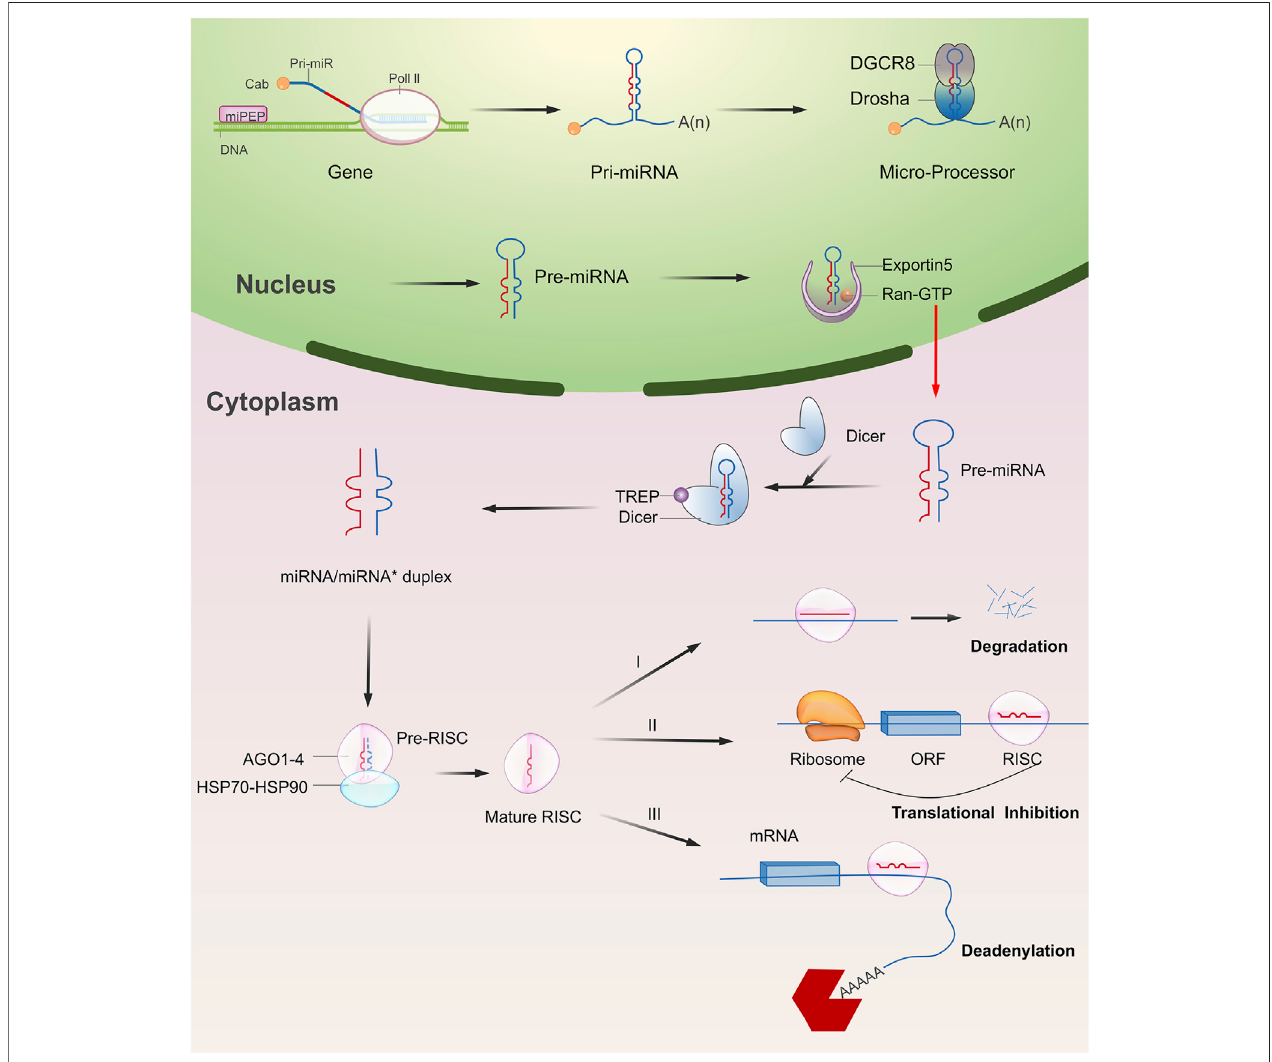
FIGURE 1 | Overview of miRNA biogenesis and functions. Typically, miRNA begins with atranscription to generate the pri-miRNA. It was next processed into pre- miRNA with hairpin structure by Drosha and DGCR8 enzymes (microprocessor complex). The pre-miRNA is then exported to the cytoplasm and forms a double stranded miRNA under the processing of Dicer enzyme. A single stranded RNA that is cleaved from the double stranded miRNA is transported and assembled into a protein complex composed of Argonaute to form a RNA induced silencing complex (RISC). In most cases, RISC binds to target mRNAs to induce translational repression, deadenylation, and